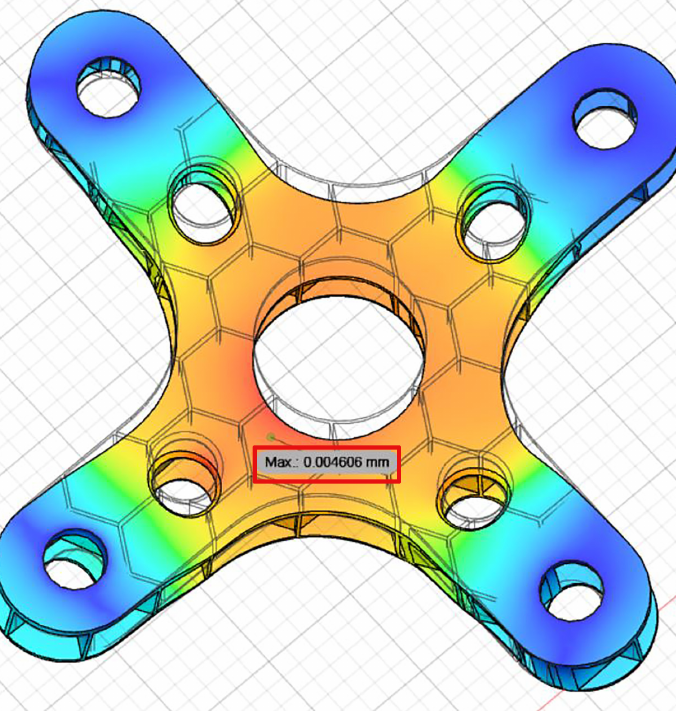
Figure 11. Evaluation of the